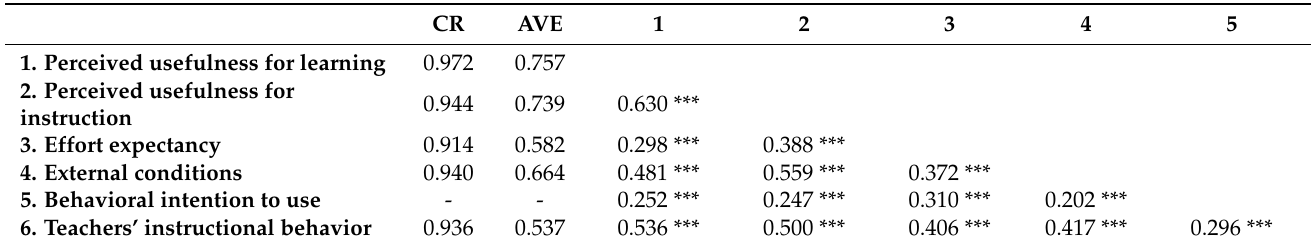
Table 3. The results of convergent (CR), discriminant validity (AVE), and correlation analysis.